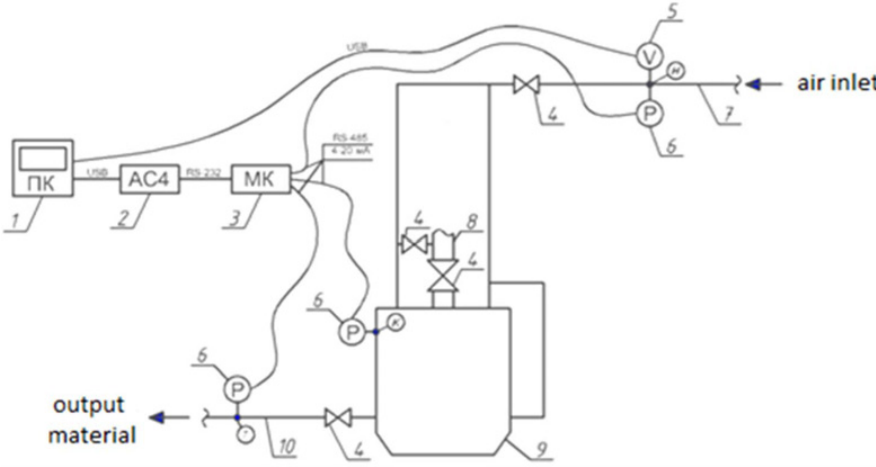
Figure 1. Diagram of the working area: 1 – personal computer; 2 – Automatic Interface Converter Oven AC4; 3 – module discrete input-output Oven MK 110-4 DN .4 R ; 4 – Valves; 5 – meter submersible EE 776; 6 – Pressure sensor type Oven PD 100- DI 1, 0-171-0,5; 7 – the air inlet; 8 – charging valve; 9 – a pneumatic chamber; 10 – the output material.